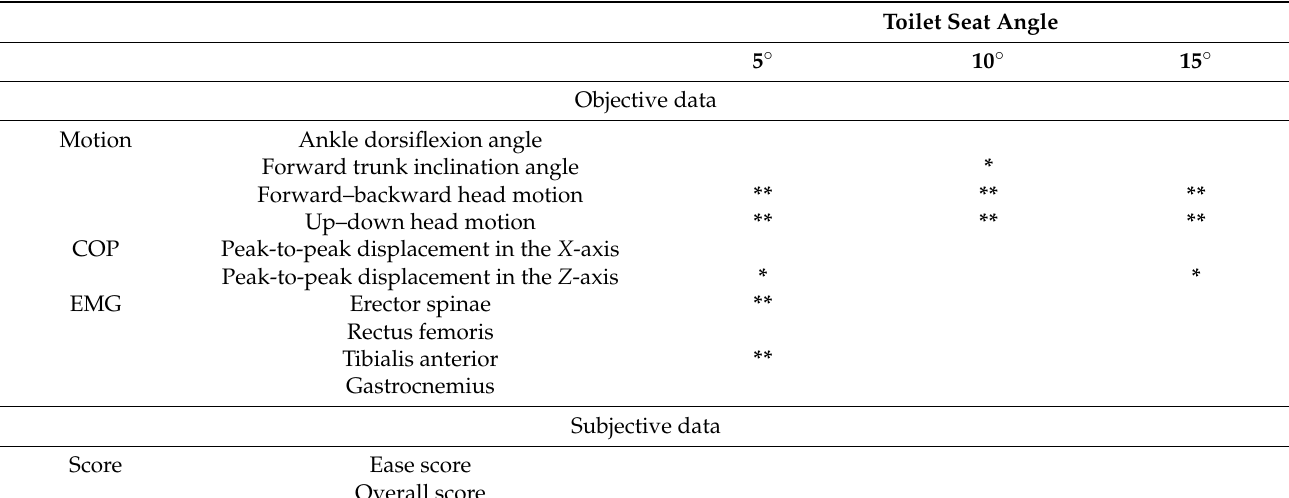
Table 2. Summary of the quantitative performance of statistically significant differences between age groups ((**) p < 0.01 and (*) p < 0.05,